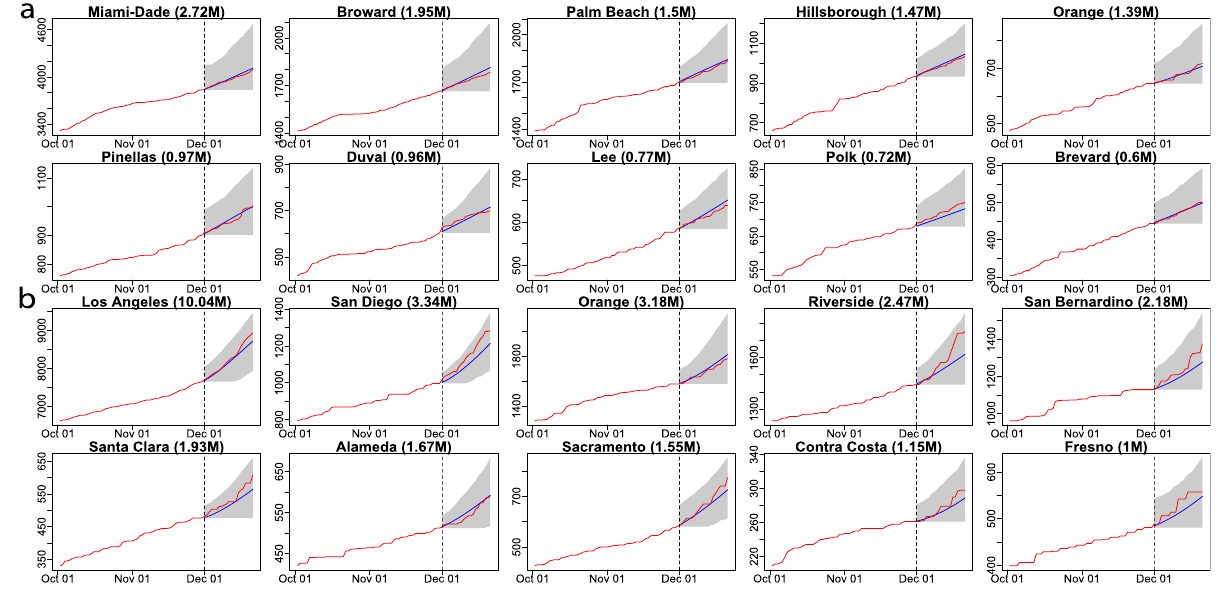
Figure 7. ( a ) The 21-day forecast in 10 counties with the largest population in Florida. The training period is from 21 March 2020 to 30 November 2020, whereas the forecast starts from 1 December 2020. The red curves are the cumulative observed death toll and the blue line indicates the forecast from 1 December 2020 to 21 December 2020. The shaded area represents the 95% predictive intervals of the forecast for each analyzed county in Florida. The numbers in the parentheses are the populations in million for each county. ( b ) the 21-day forecast in 10 counties with the largest population in California. The interpretations are the same as ( a ).